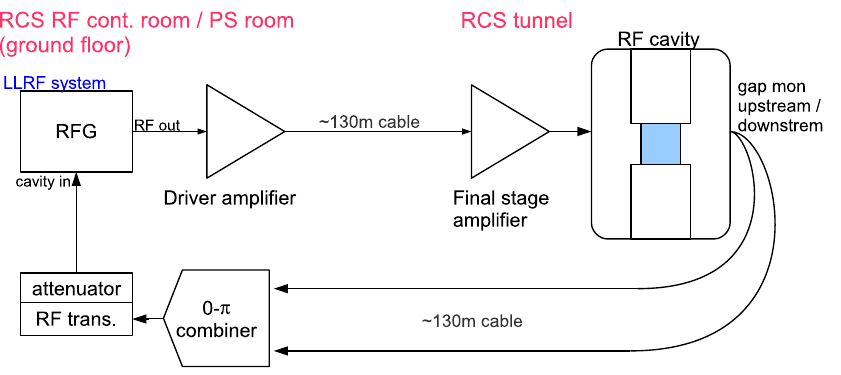
FIG. 12. Configuration of the RCS rf